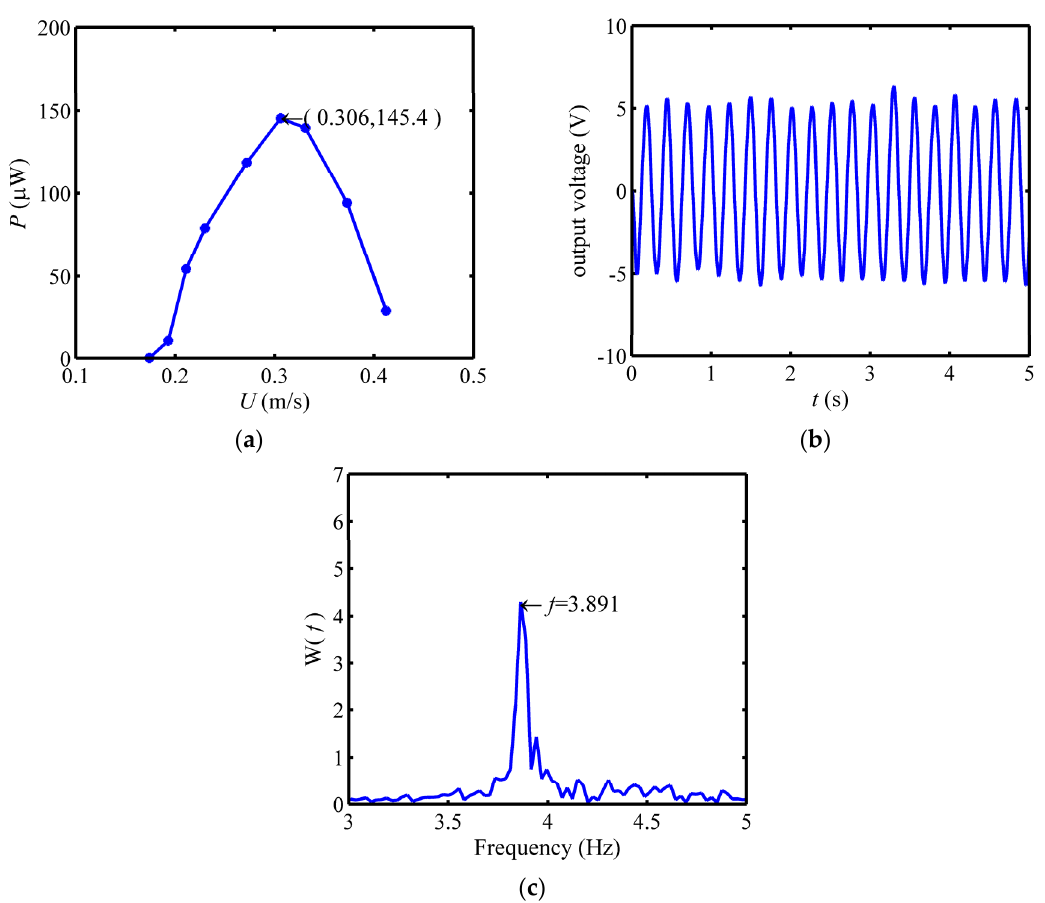
Figure 5. Performance of the upstream harvester at the spacing ratio L / D = 3.3: ( a ) Output power of the upstream harvester as a function of the water speed; ( b ) Time history of the output voltage at the water speed of 0.306 m/s; ( c ) FFT analysis of the output voltage at the water speed of 0.306 m/s.